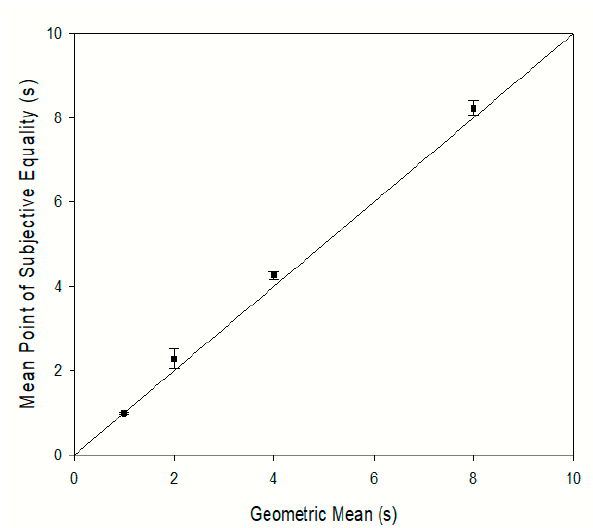
Figure 2. The Point of Subjective Equality (PSE) as a function of the geometric mean of the two trained extreme durations in each condition. The error bars are the standard error of the mean.